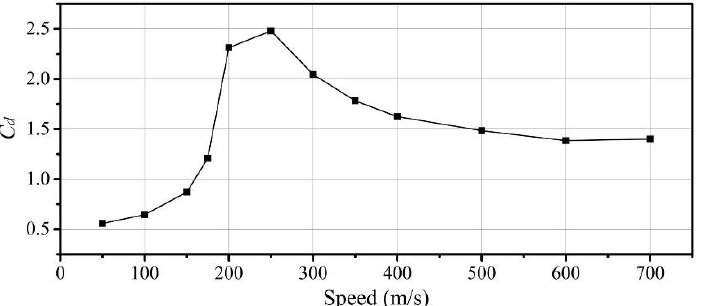
Figure 11. Relationship between the drag coefficient and travelling speed.